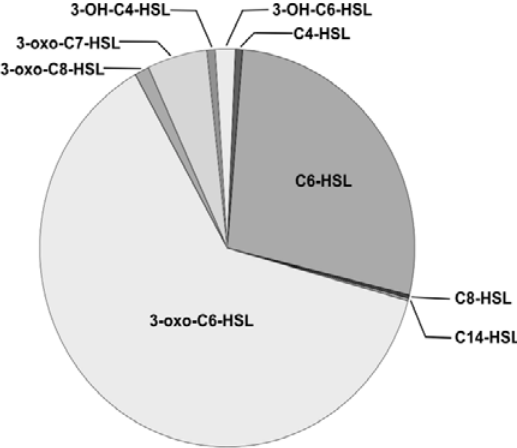
Figure 2. Pie chart illustrating the relative molar ratios of AHL lactone-dependent (AHLs) identified in Y. enterocolitica 8081. N -(3-oxohexanoyl)homoserine lactone (3-oxo-C6-HSL) (62.4%) is the major AHL, followed by N -hexanoylhomoserine lactone (C6-HSL (27.4%) and N -(3-oxoheptanoyl) homoserine lactone (3-oxo-C7-HSL) (5.1%). Low levels of N -(3-oxooctanoyl)homoserine lactone (3-oxo-C8-HSL); N -(3-hydroxybutanoyl)homoserine lactone (3-OH-C4-HSL); N -(3-hydroxyhexanoyl)homoserine lactone (3-OH-C6-HSL); N -butanoylhomoserine lactone (C4-HSL) ; N -octanoylhomoserine lactone (C8-HSL); (N-tetradecanoylhomoserine lactone (C14-HSL) were also present.